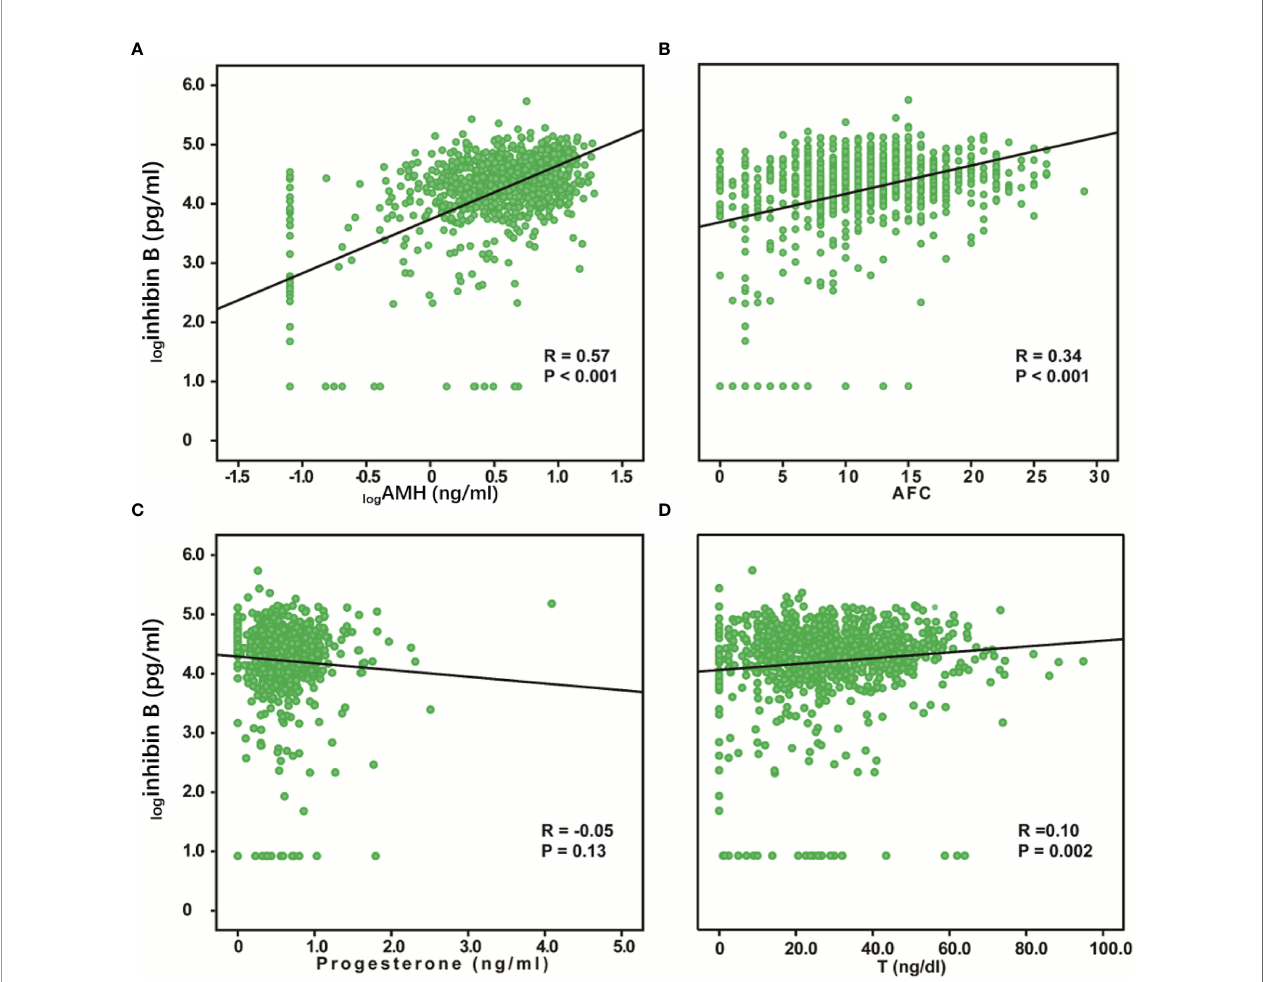
FIGURE 4 | Relationship between serum inhibin B levels and AMH, AFC, Progesterone, and T. log Inhibin B was signi fi cantly positively correlated with log AMH (R = 0.57, P < 0.001) (A) , AFC (R =0.34, P < 0.001) (B) , and T (R = 0.10, P =0.002) (D) . No correlation was found between log Inhibin B and progesterone (R = -0.05, P =0.13) (C)